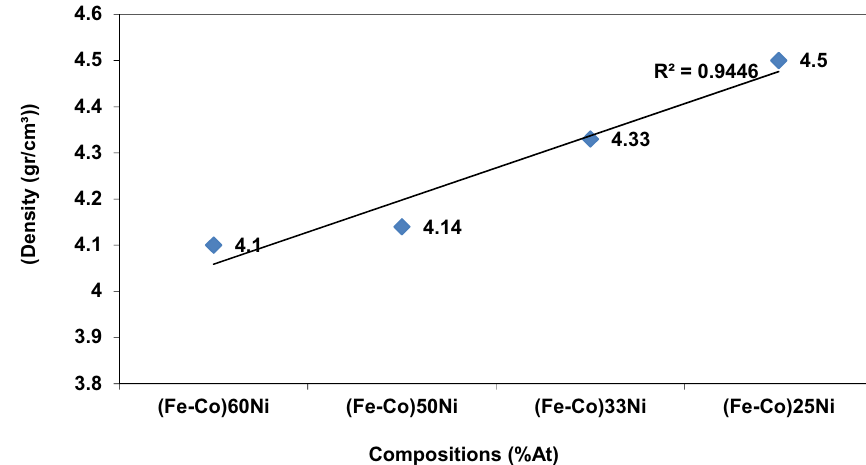
Figure 2: Density – hardness – composition curve in